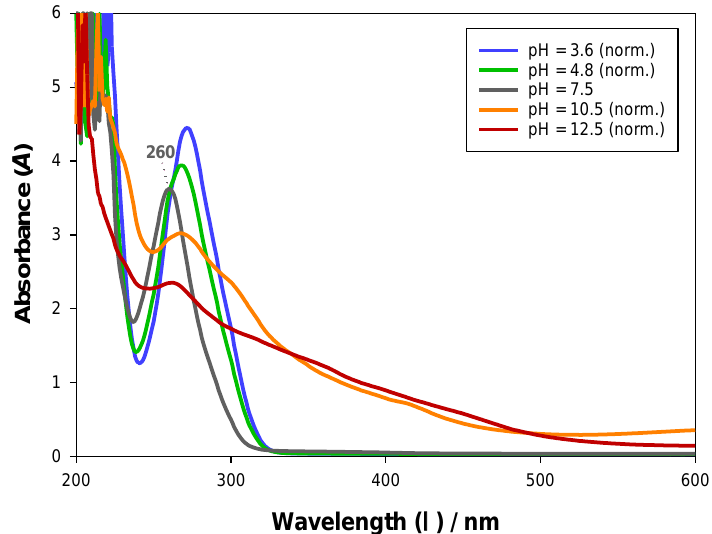
Figure 2. Influence of pH on the UV-Vis absorbance spectra of gallic acid (~1.5·10 −4 g·mL −1 ) at 298.15 K and 0.1 MPa.